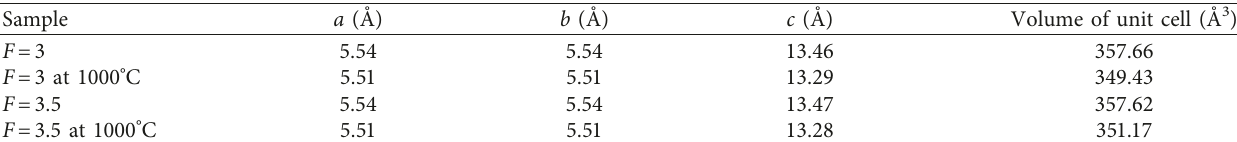
Table 2: The lattice parameter of the LaMnO 3 samples with different ratios of glycine/nitrate molar ( F (cid:31) 3 and 3.5) before and after annealing at 1000 ° C for